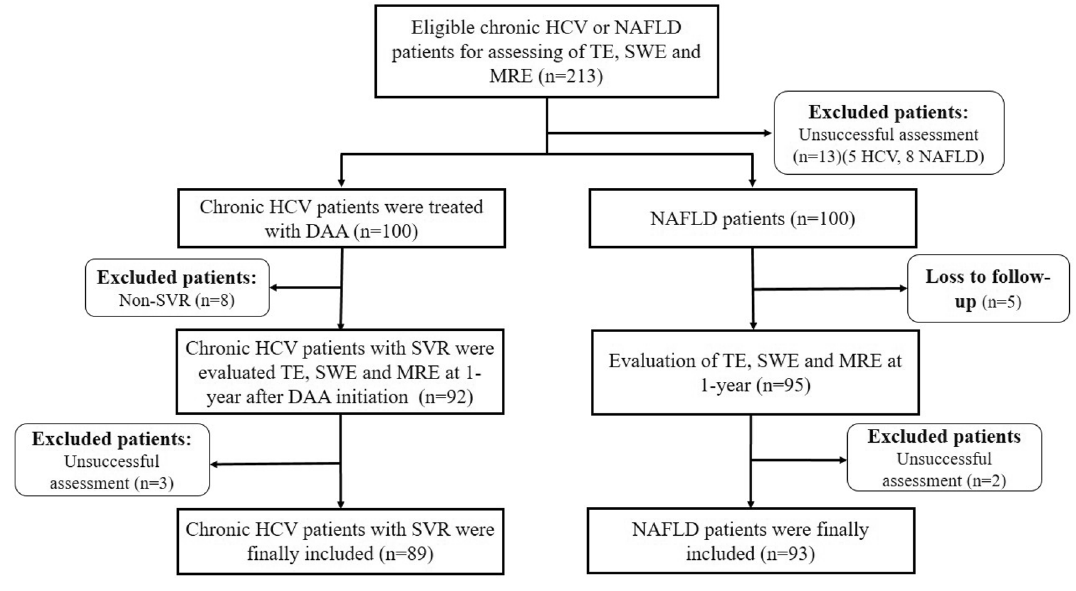
Figure 1. Flow chart of patient